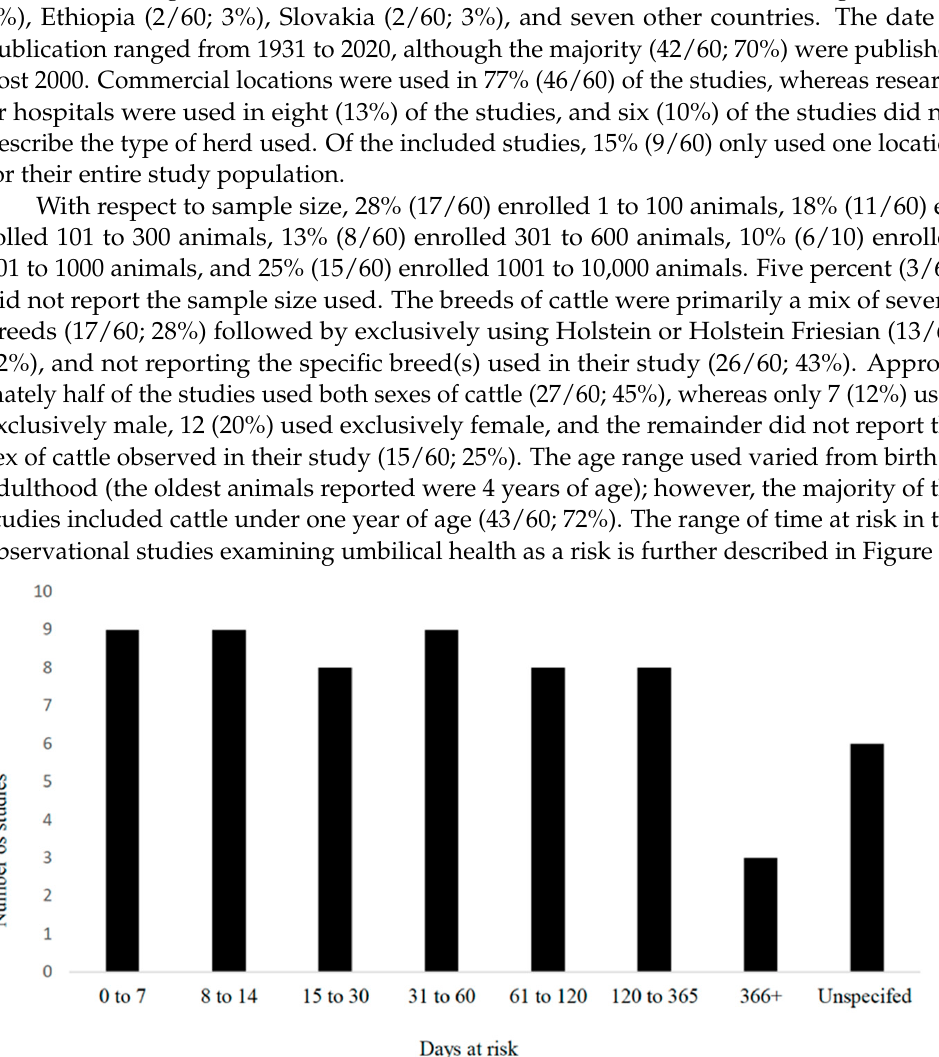
Figure 5. Time at risk (days) for development of outcomes in observational studies examining umbilical health as a risk factor ( n = 60) included in the scoping review of literature surrounding umbilical health in intensively raised